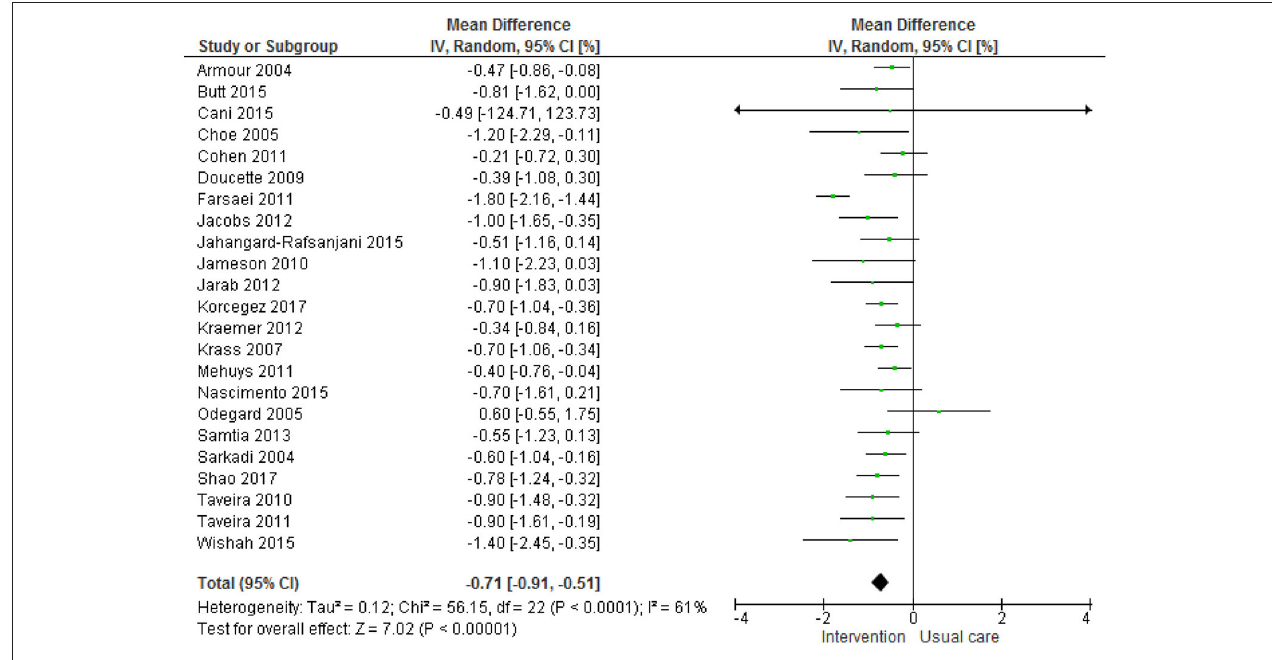
FIGURE 2 | Meta-analysis